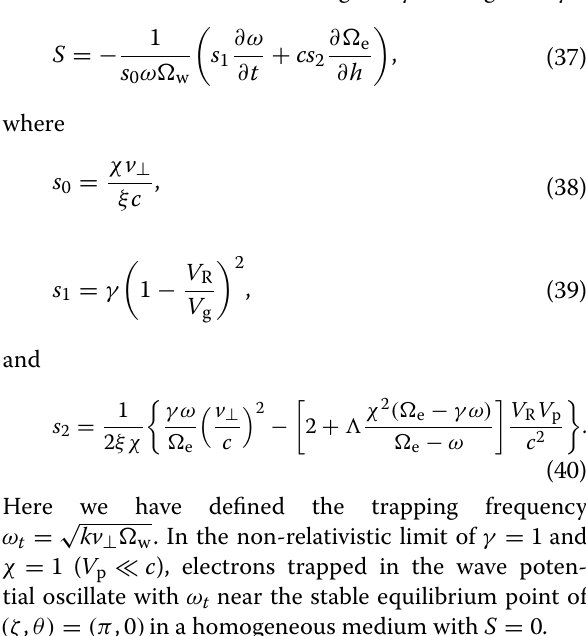
Fig. 2 Nonlinear trapping potential. Trajectories of electrons surrounding the nonlinear trapping potential in the velocity phase 4.5 , Q 0.5 , and n h / n c 0.5 , τ space (ζ , θ) . L = = = Omura et al.